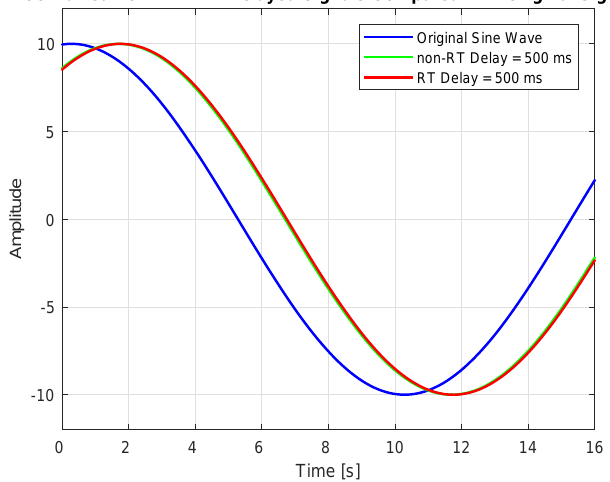
Figure 13. Original sine wave signal compared with delayed signals received from non-RT and RT test setups with MSE of 2.086 × 10 − 2